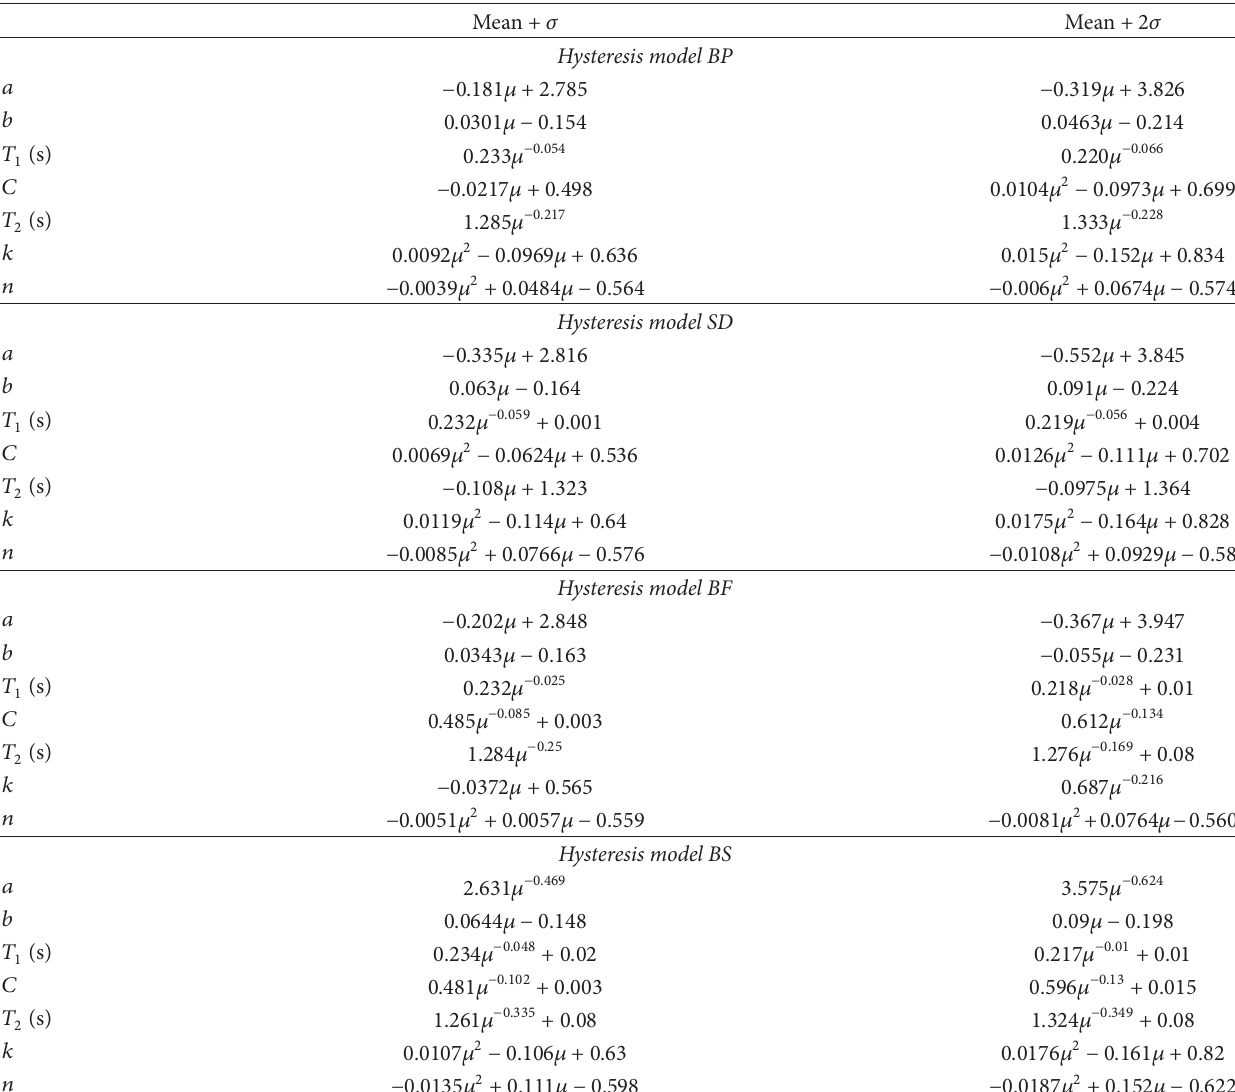
Table 6: Normalized input energy spectral shape parameters (site class